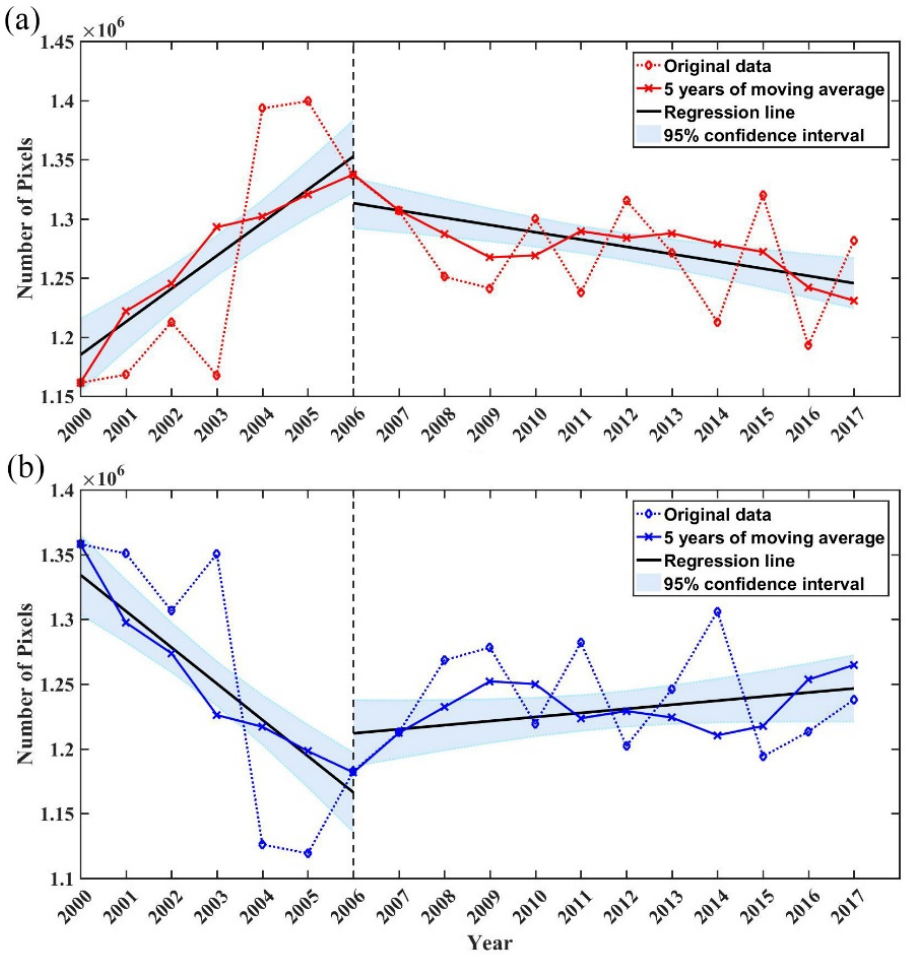
Figure 5. Trend of pixel numbers of ( a ) heat island and ( b ) cool island from 2000 to 2017. From 2000 to 2017, the variation trend of the pixel number of the heat island, namely the total sUHI area, in the 6th Ring Road of Beijing increased first and then decreased, and there was an obvious turning point in 2006. In the limited region, the sum of heat and cold island pixels was fixed, so their variation trends were opposite. Based on the statistic results of pixel numbers of different sUHI intensities, the propor- tional area of weak sUHI increased from 20.1% in 2000 to 31.1% in 2017. In contrast, the proportional area of medium and strong sUHIs decreased from 20 and 5.9% to 16.6 and 3.4%, respectively, for that same period. From 2000 to 2017, the area of weak sUHI increased first and then decreased slightly. The turning point of the trend occurred in 2009. The variation in the trend of medium sUHI was similar to that of strong sUHI. Both showed a decrease from 2000 to 2009, after which they remained stable. The number of extreme sUHI pixels was significantly small (less than 2500), and the variation trend of pixels